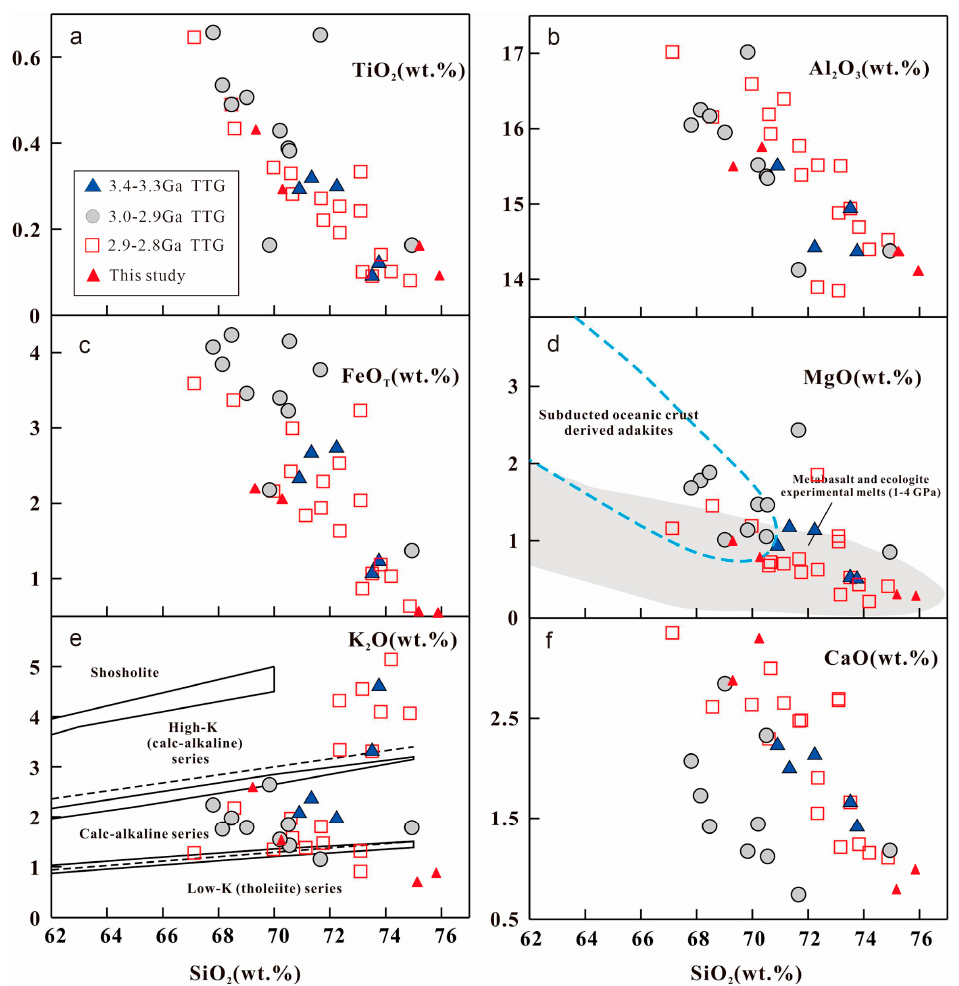
Figure 17. Diagrams of gneissic granitoids from the Northern Kongling Terrane, showing SiO 2 vs. ( a ) TiO 2 , ( b ) Al 2 O 3 , ( c ) FeO T , ( d ) MgO, ( e ) K 2 O, and ( f ) CaO. Symbols: blue triangles, TTGs; gray circles,